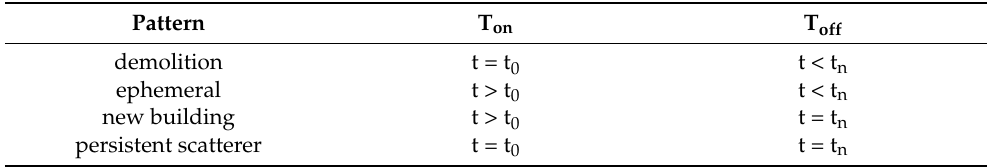
Table 2. Typical patterns in urban areas.